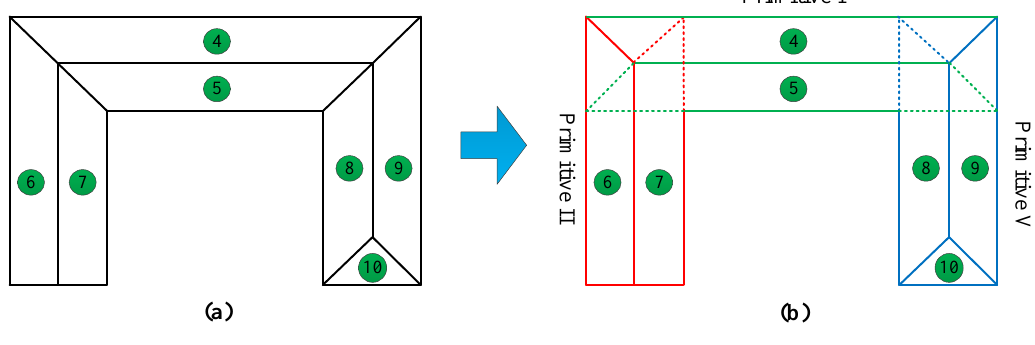
Figure 7. Semantic decomposition allowing the overlapping of neighboring primitives. ( a ) A compound building; and ( b ) decomposition result of the proposed